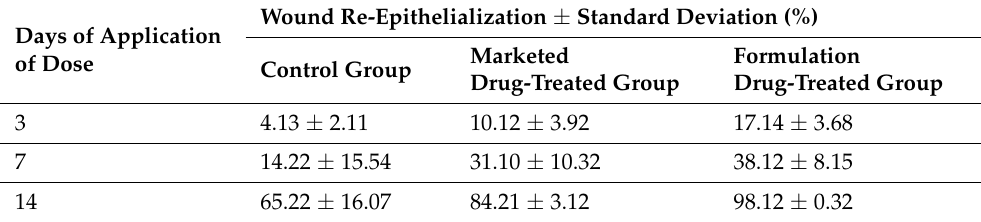
Table 5. Rate of re-epithelialization of wounds at the 3rd, 7th, and 14th day ( n = 6). Wound Re-Epithelialization ± Standard Deviation Days of Application of Dose